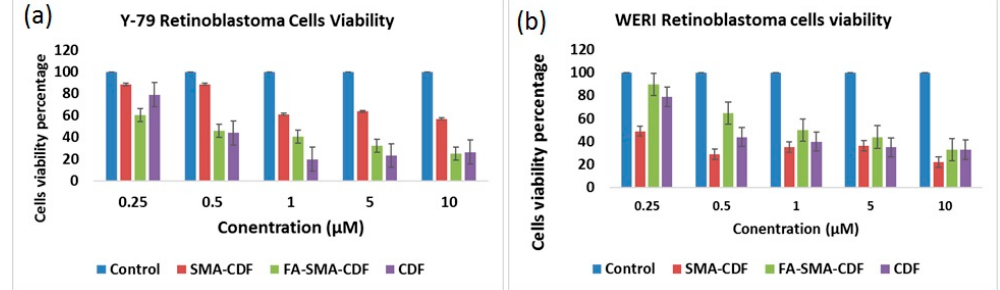
Figure 5. ( a ) In vitro cell viability assay showing the percentage of cell viability observed at 48 h after treating Y-79 cells with various formulations is shown ( n = 8); ( b ) MTT assay observed at a 48-h treatment of WERI-RB1 cells with SMA-CDF and FA-SMA-CDF as compared to the same treatment is shown ( n = 8).